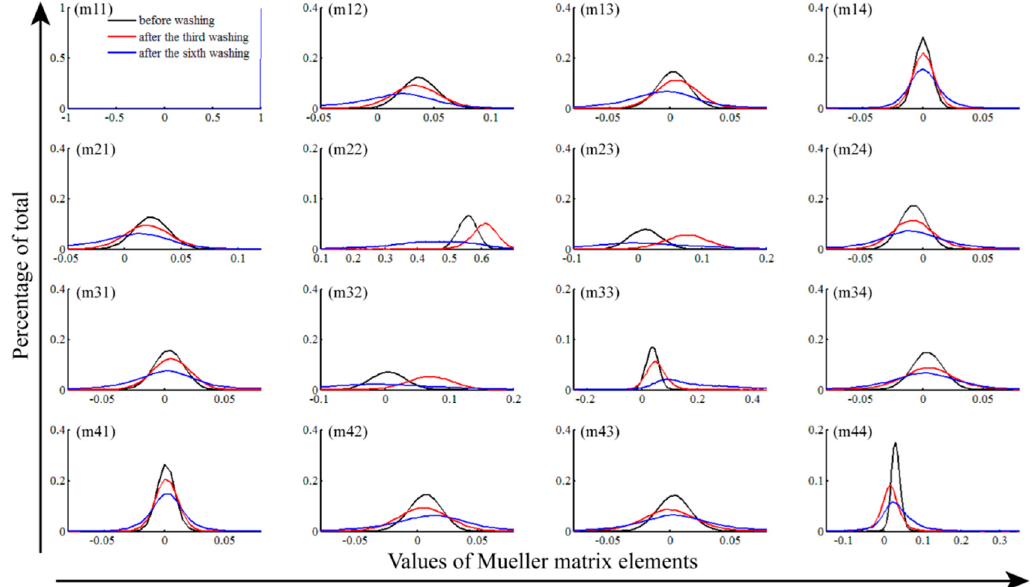
Figure 4. Frequency distribution histograms (FDHs) of Mueller matrix elements of silk sample washed by the color stain net: before washing (black lines), after the third wash (red lines) and the sixth wash (blue lines). The areas under the FDH curves are normalized to 1, and the horizontal axis is divided into 400 parts.